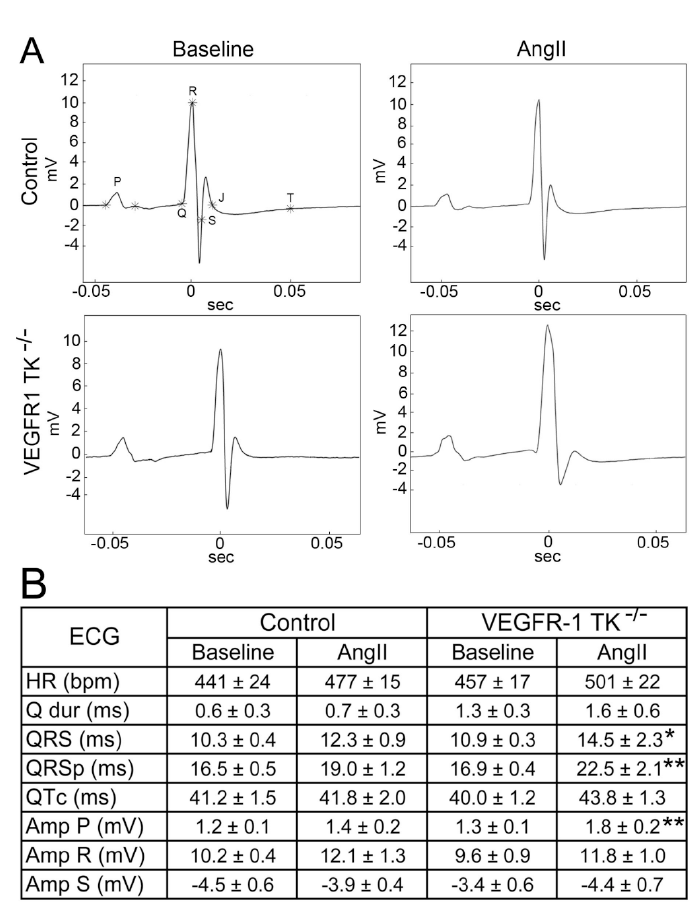
Figure 3. Deletion of VEGFR-1 signaling leads to QRSp prolongation after pressure overload. ( A ) Rep- resentative electrocardiographs of baseline and day 14 of angII infusion. ( B ) Electrocardiographic measurements during baseline and LVH (n = 7–13/group). Values are mean ± SEM. Statistical anal- yses were performed using Student ´ s t -test. *** p < 0.001; ** p < 0.01; * p < 0.05. Amp indicates amplitude; BPM, beats per minute; HR, heart rate; ms, millisecond; mV